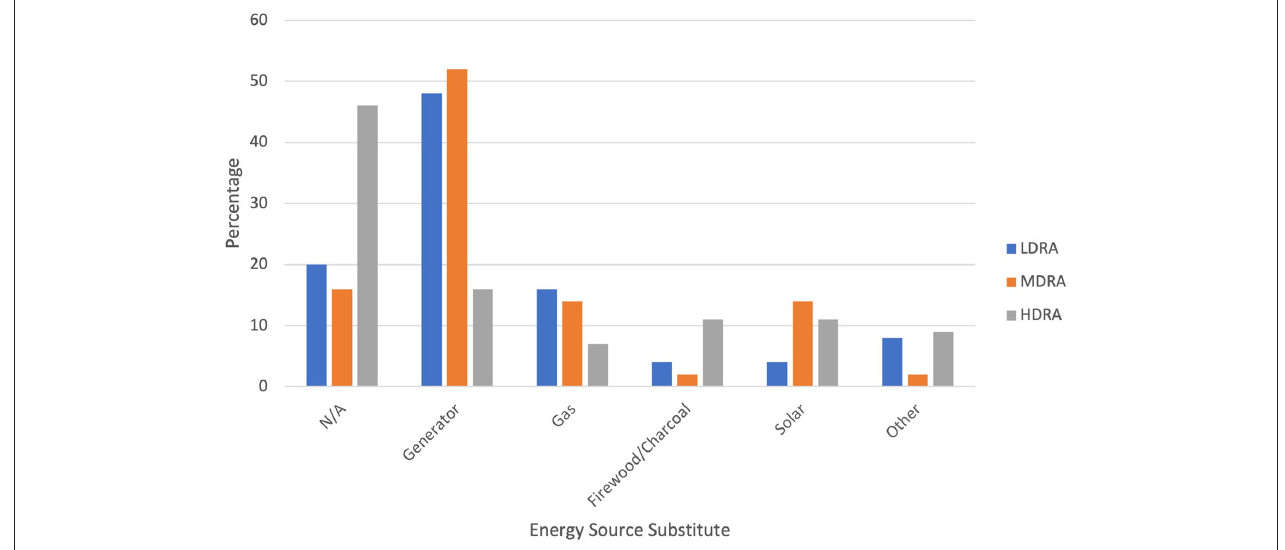
FIGURE 7 | Types of electricity substitutes in different residential areas. Source: Field survey (2018).